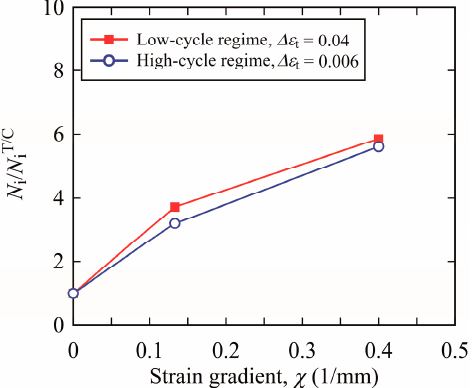
Figure 11. Influence of strain gradient on crack initiation life.